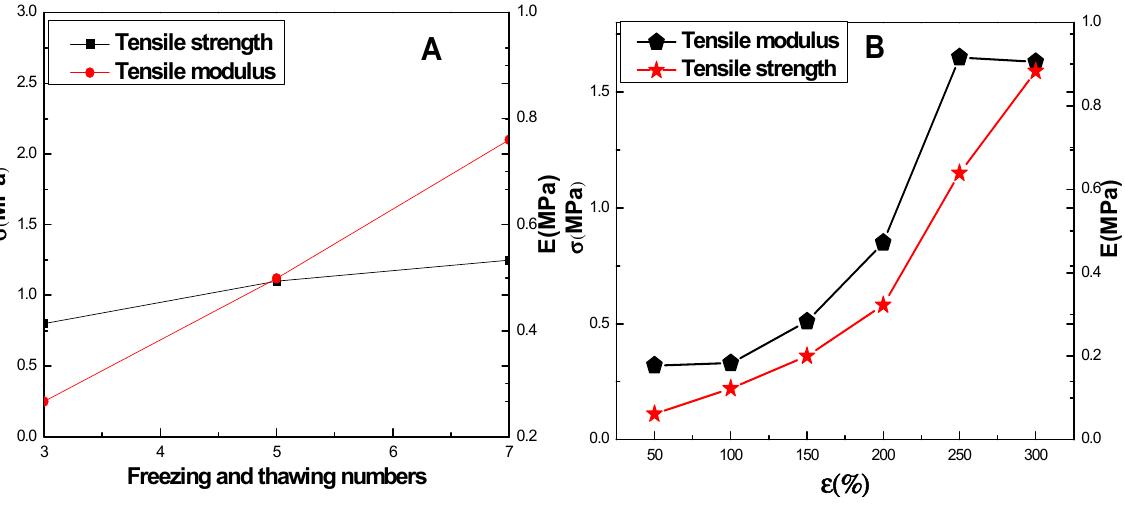
Figure 2. Tensile strength and Young’s modulus of CMCS/PVA hydrogels. ( A ) Tensile strength and modulus with varying numbers of freezing–thawing cycles; ( B ) variation law of stress and instantaneous tensile modulus with strain.